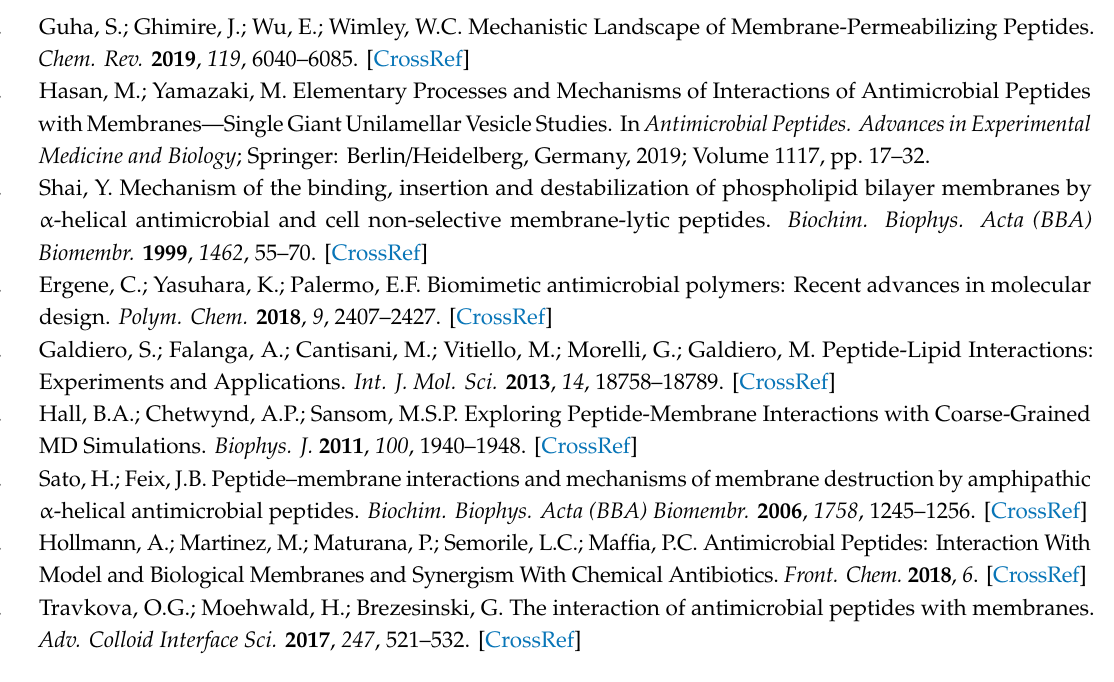
Figure S1. Scheme showing a trapped GUV isolated by a donut valve; Figure S2. Wide-field fluorescence image of a single GUV trapped hydrodynamically by the posts; Figure S3. OD 403 originating from light scattering (turbidity) of the vesicles present in the fractions eluting up to an elution volume of about 12 mL, and HRPC activity of the di ff erent fractions, measured with ABTS 2 − / H 2 O 2 as substrates. Figure S4. Changes of the absorption spectrum of the reaction solution as a function of reaction time; Figure S5. HRPC concentration dependency of the absorbance of the reaction solution at 414 nm; Figure S6. Snapshot of the starting configuration of both peptide / POPC-POPG systems and the last frame at 50 ns of simulation time. Figure S7. Order parameter SCD for (a) the unsaturated oleic and (b) the saturated palmitoyl acyl chains of phospholipids in POPC / POPG /